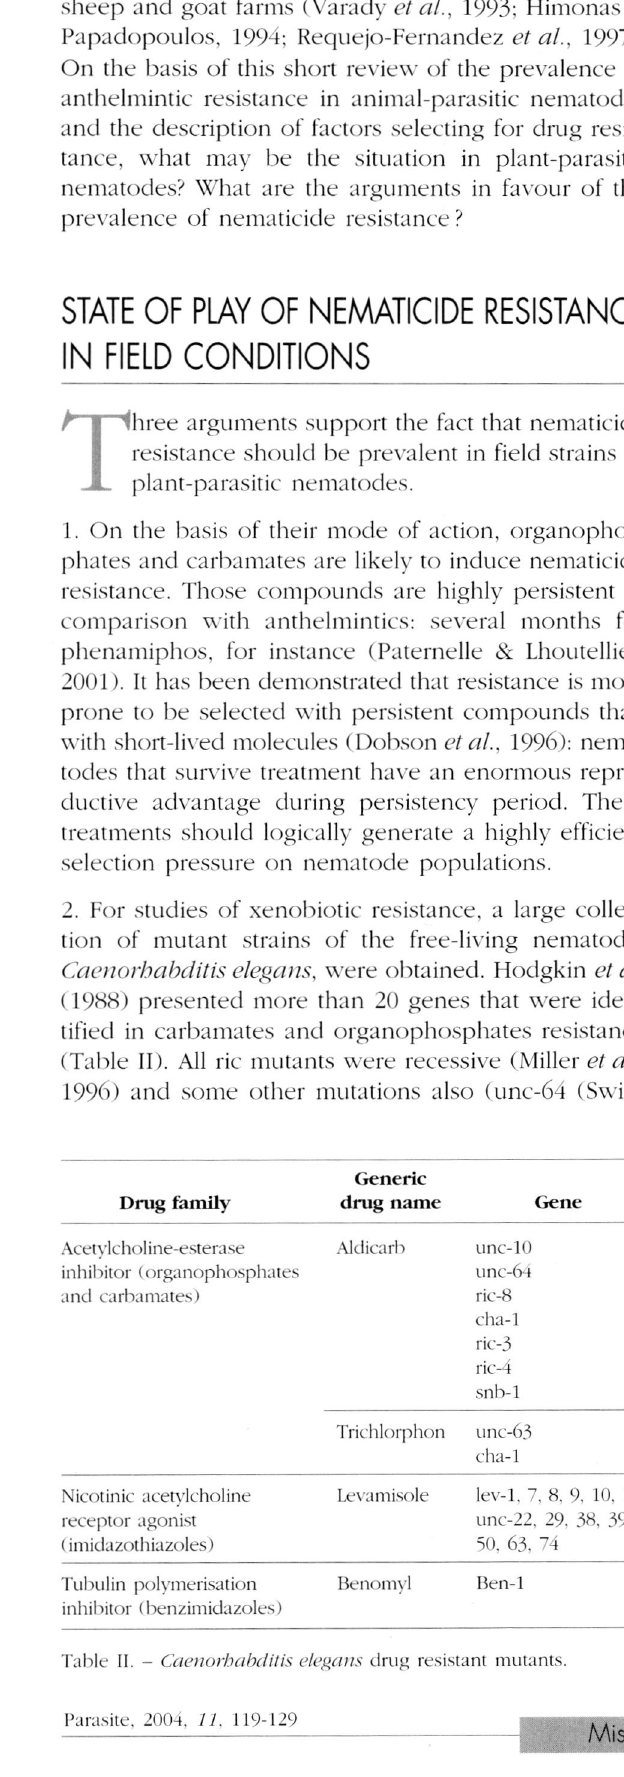
Table II. - Caenorhabditis elegans drug resistant